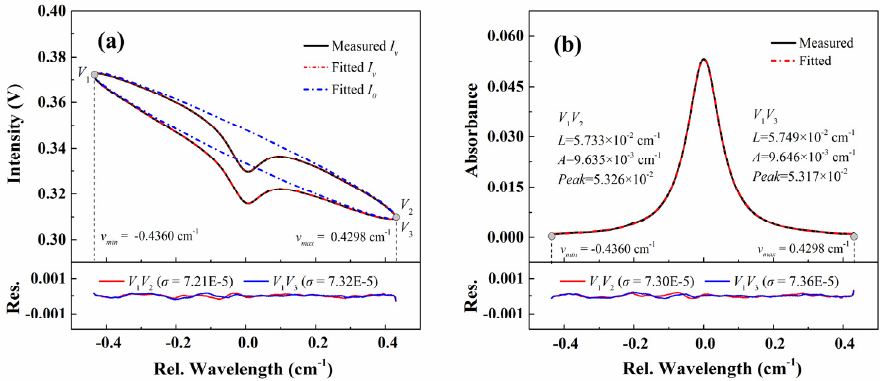
Figure 7. ( a ) Best-fit transmitted light intensity and baseline from the proposed WM-DAS. ( b ) The measured absorbance calculated with the best-fit baseline. The experimental conditions are: CO/N 2 mixture gas, T = 299 K, L = 14.7 cm, Xco = 1.02%, P = 101.3 kPa.